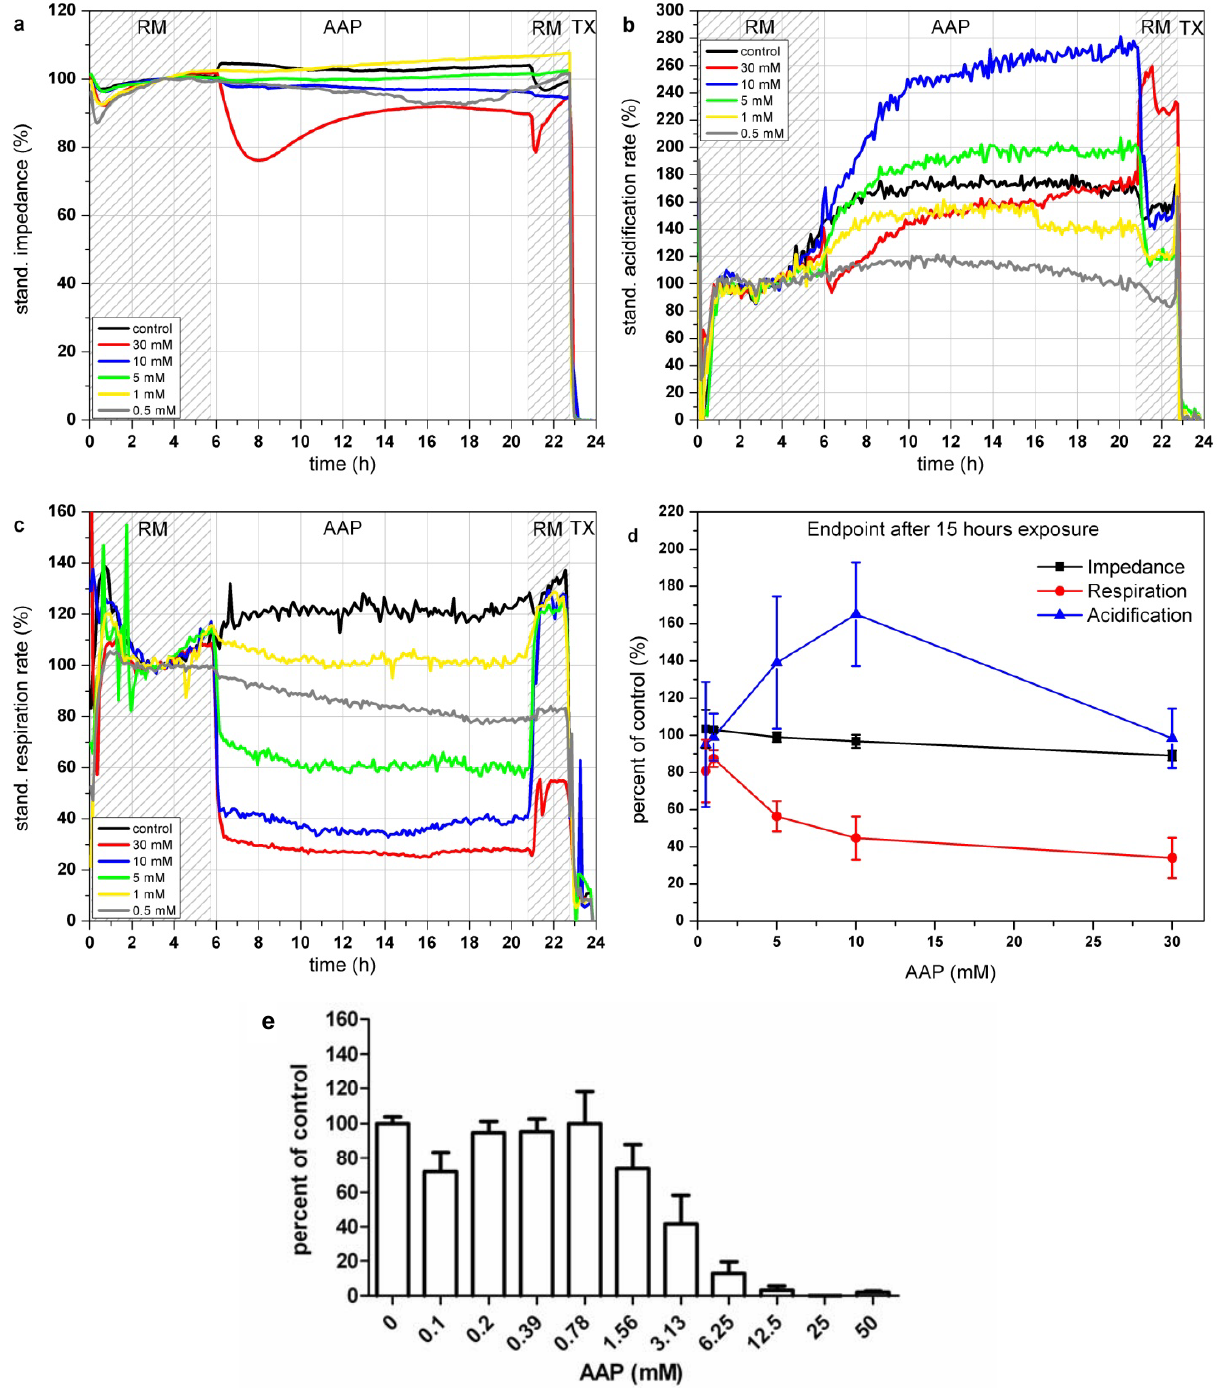
Figure 6. Time course of the impedance ( a ), acidification ( b ) and respiration ( c ) of L6 rat skeletal muscle cells during 24 h incubation with Acetaminophen in the Bionas 2500 Analyzing System. Vehicle control (black), 4.530 mg/L (30 mM, red), 1.510 mg/L (10 mM, blue), 755 mg/L (5 mM, green), 151 mg/L (1 mM, yellow) and 75.5 mg/L (0.5 mM, grey). Phases with running medium (RM) represent culture medium treatment without added substances. ( d ) Percent of control of impedance, respiration and acidification endpoint values measured after 15 h of AAP exposure (n = 3). ( e ) Results of BrdU assay of L6 cells incubated with AAP for 24 h.